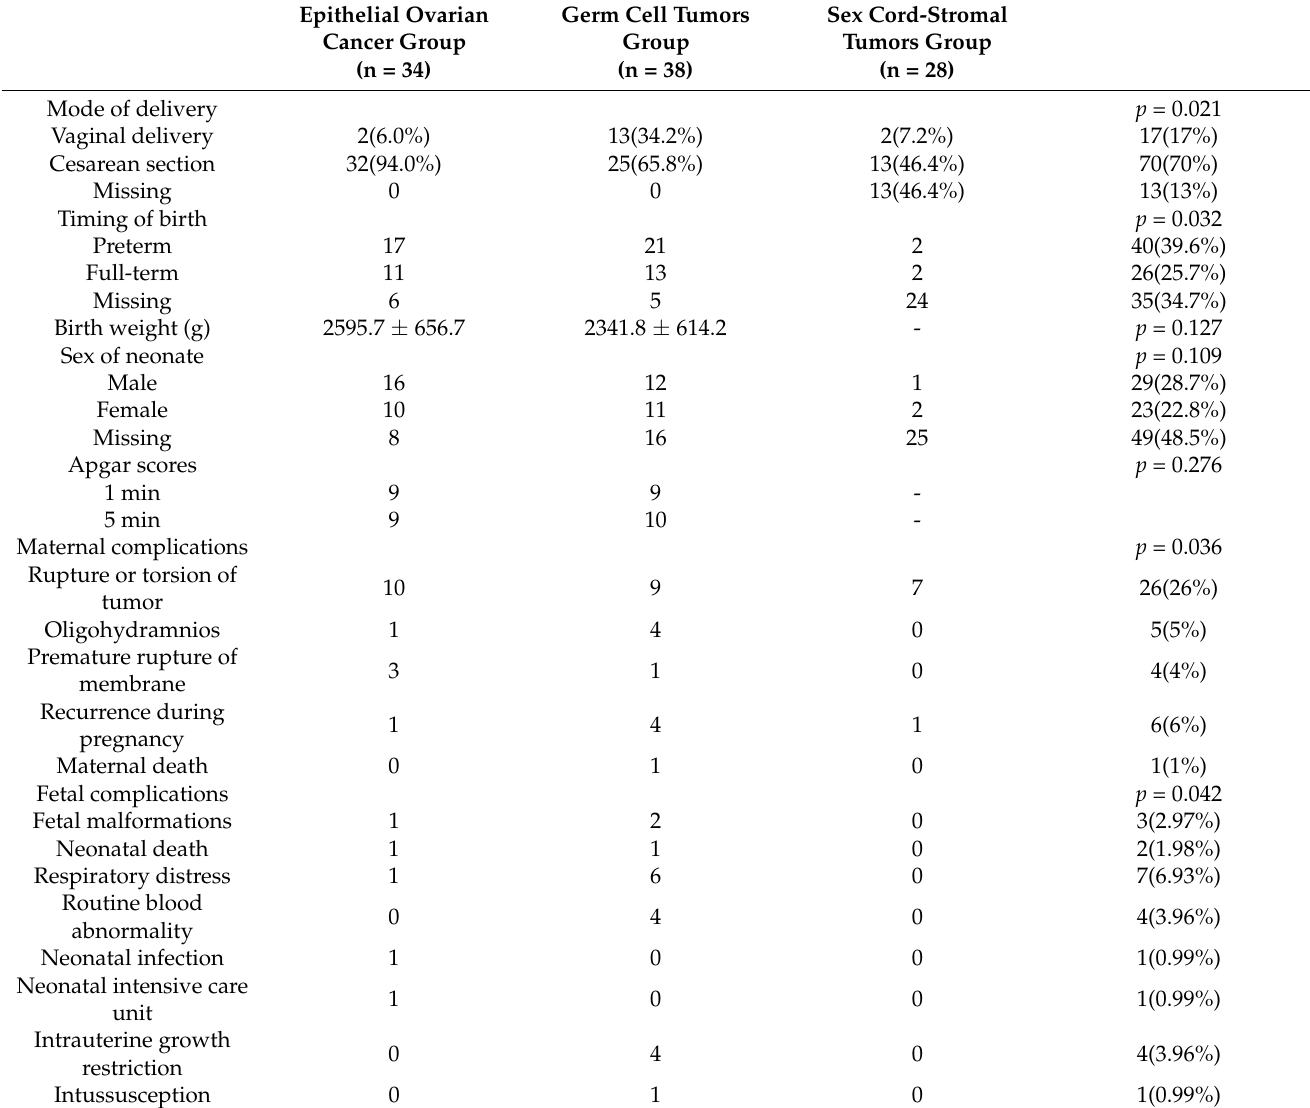
Table 2. Maternal and neonatal outcomes of pregnant patients complicated with ovarian